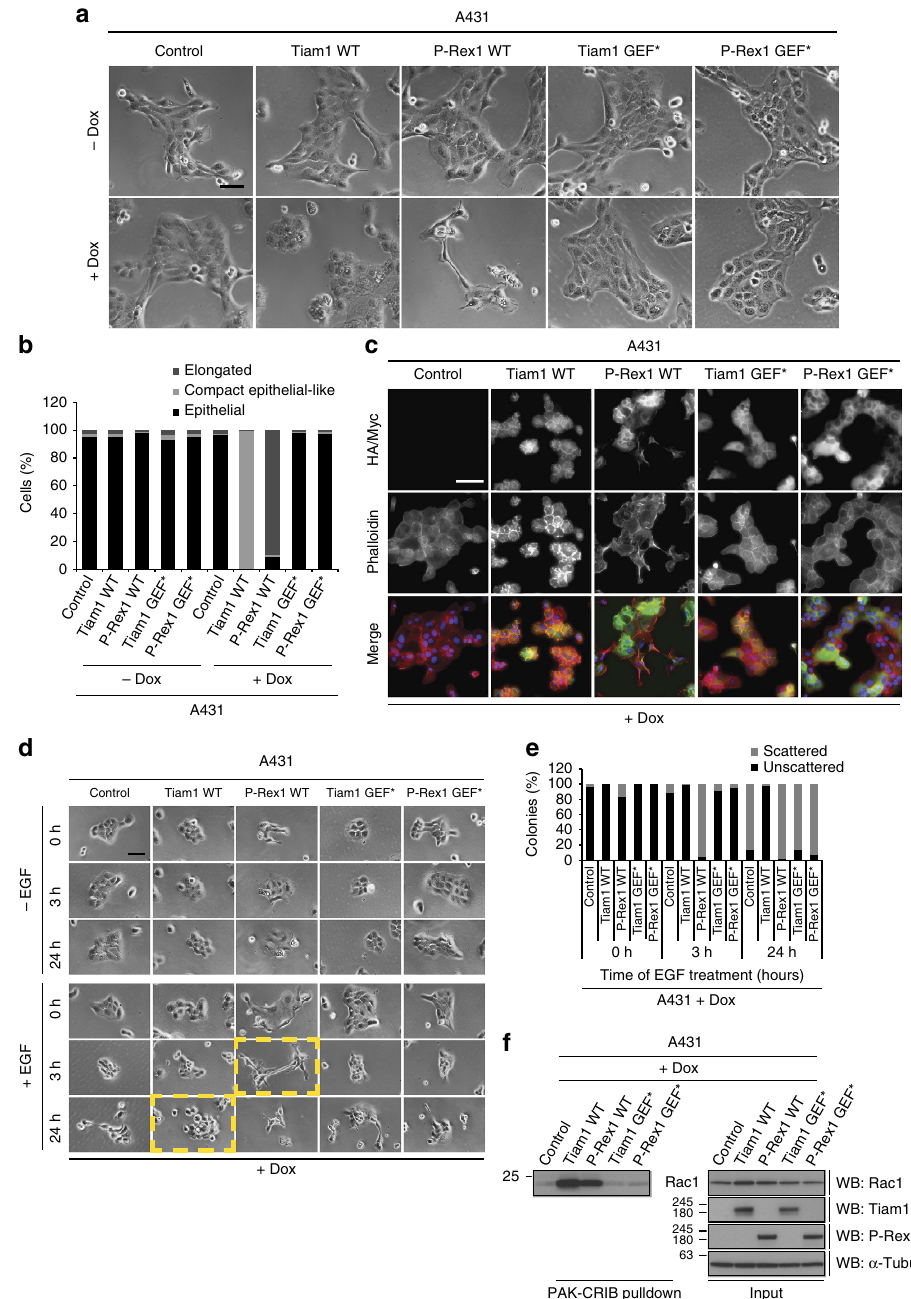
Figure 2 | Activation of Rac1 by Tiam1 or P-Rex1 induces differential effects in A431 cells. ( a ) Representative phase-contrast images of A431 cells treated with ethanol ( (cid:2) dox) or 1 m gml (cid:2) 1 doxycycline ( þ dox) for 24h to induce expression of indicated GEF constructs. Scale bar, 100 m m. ( b ) Quantification of GEF-induced cellular phenotypes depicted in a . Graph represents per cent cells with the indicated morphology from a total of 150 cells per condition from three independent experiments. ( c ) Representative immunofluorescence images of þ dox treated A431 cells fixed in 4% formaldehyde. Phalloidin staining was used to visualize the actin cytoskeleton and antibodies against HA-tagged Tiam1 WTand GEF* or Myc-tagged P-Rex1 WTand GEF* to detect the expression of the respective GEFs upon dox induction. DAPI was used to stain the nuclei. Scale bar, 100 m m. ( d ) Representative phase-contrast images of þ dox treated A431 cells either left untreated ( (cid:2) EGF) or treated with 100ngml (cid:2) 1 epidermal growth factor ( þ EGF) for the indicated times following serum starvation for 18–24h. Yellow boxes are used to highlight the differential effects of Tiam1 WTand P-Rex1 WTon cell scattering at indicated time points. Scale bar, 100 m m. ( e ) Quantification of cell scattering of þ dox treated A431 cells described in d . Graph represents per cent of scattered or unscattered colonies from a total of 50 colonies per condition from three independent experiments. ( f ) Lysates from A431 cells following þ dox treatment for 24h to induce expression of indicated GEF constructs were subjected to PAK-CRIB pulldown. Levels of active and total Rac1 were detected by western blot analysis. a -Tubulin was used as a loading control. Representative western blot from three independent